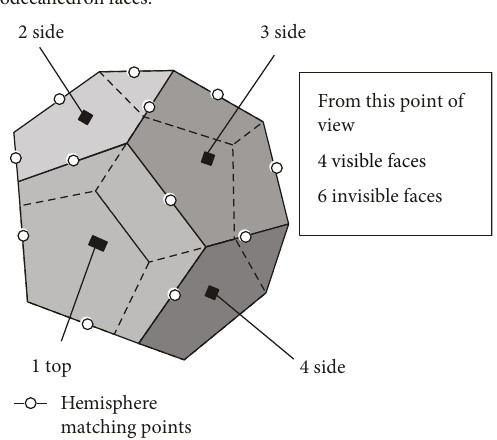
Figure 3: Approximation of the spherical inner wall of the combustion chamber by dodecahedron with pentagon-shaped fl at surfaces. Distributed over them were 3 × 2 × (16+ 8+ 4) =168 exit holes. The white points are the locations of the pentagon edges corresponding to the ideal spherical